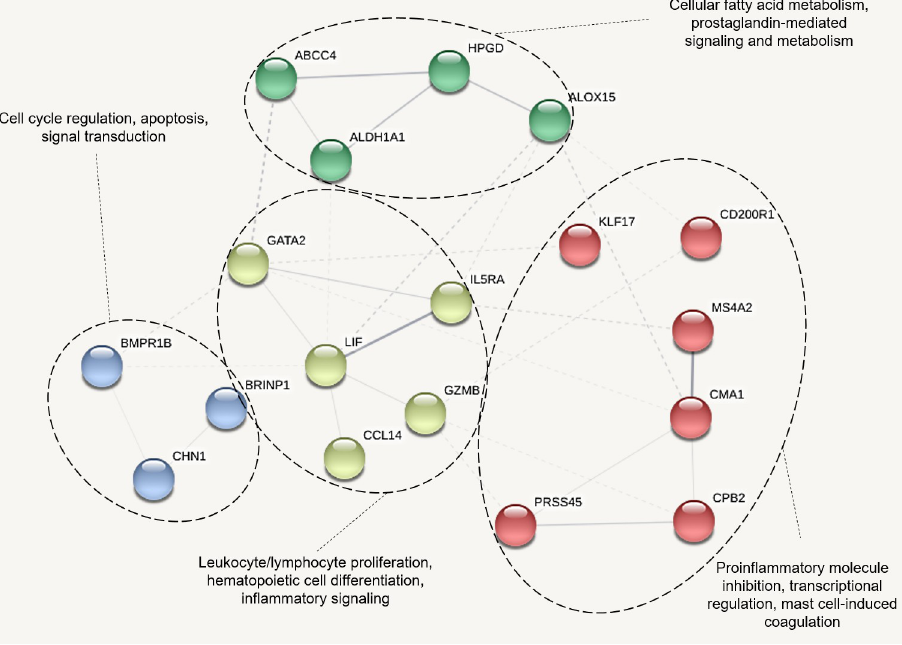
Fig 4. Protein network of DEGs expressed higher in healthy animals. K-means clustering performed based on product functionality. Edge (line) thickness between nodes represents the strength of data support for associations.